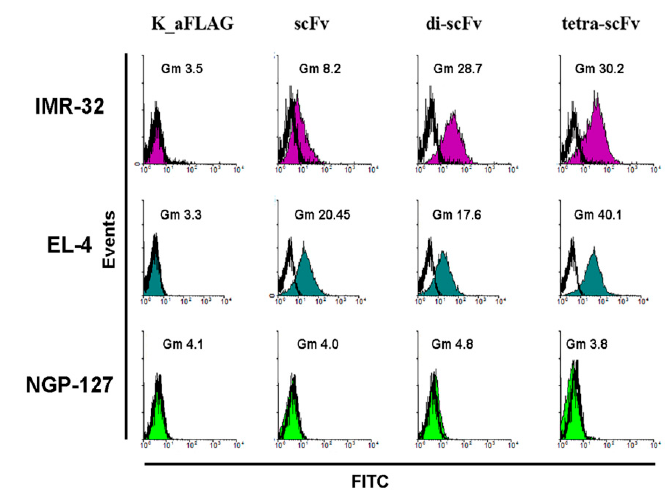
Figure 6. Flow cytometry analysis. Incubation of IMR-32, EL-4, and NGP-127 cell lines with intact scFv fragments, di-scFv-PEG, and tetra-scFv-PEG, followed by staining with fluorescein-5-isothiocyanate (FITC)-labelled anti-FLAG antibodies (1:500). K_aFLAG—Control cells stained only with FITC-labelled anti-FLAG